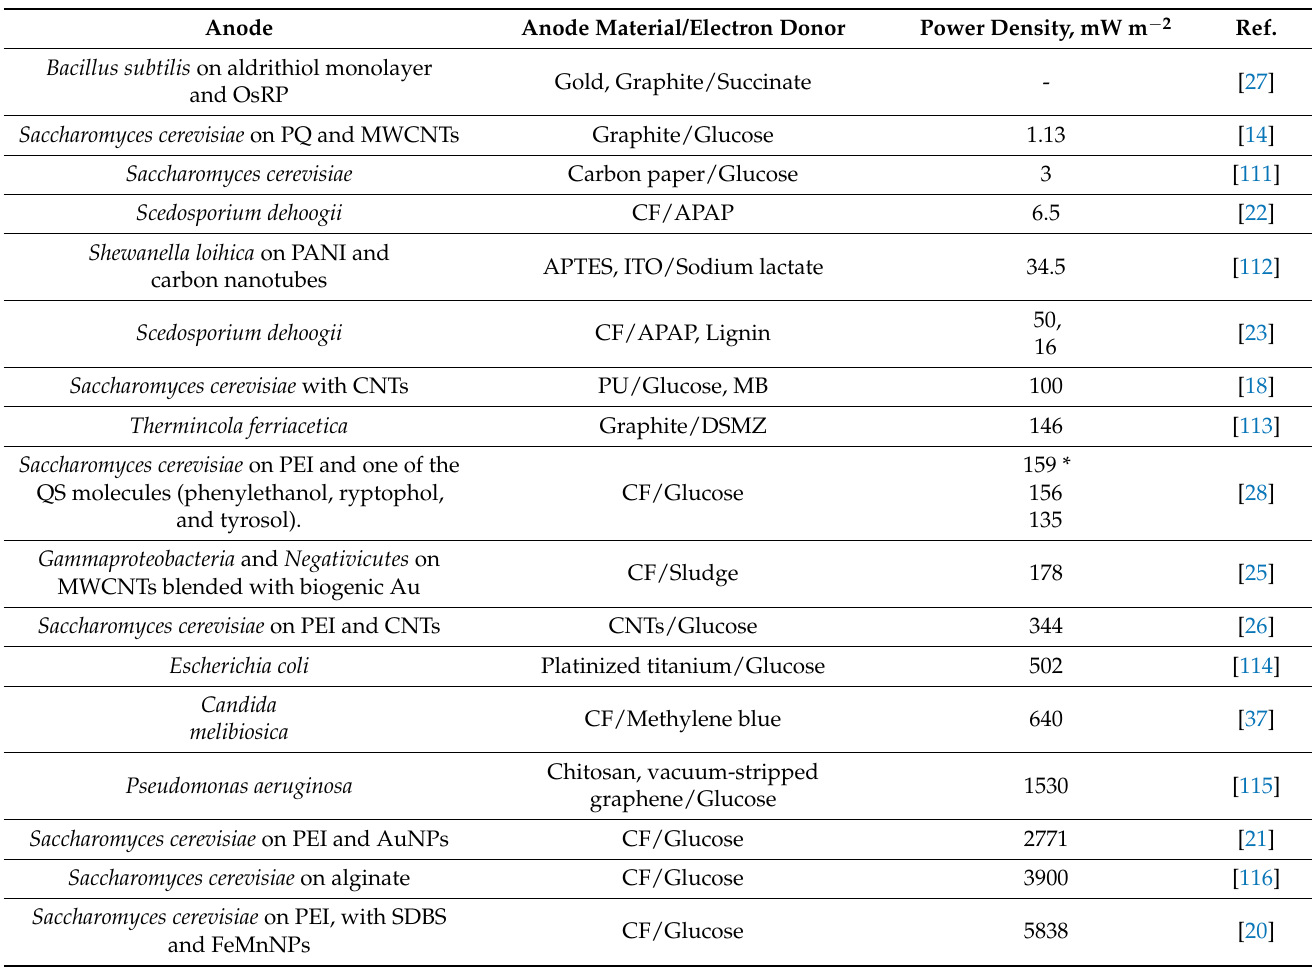
Table 2. Description of the MFC anode modification method and performance. Abbreviations are provided below the table